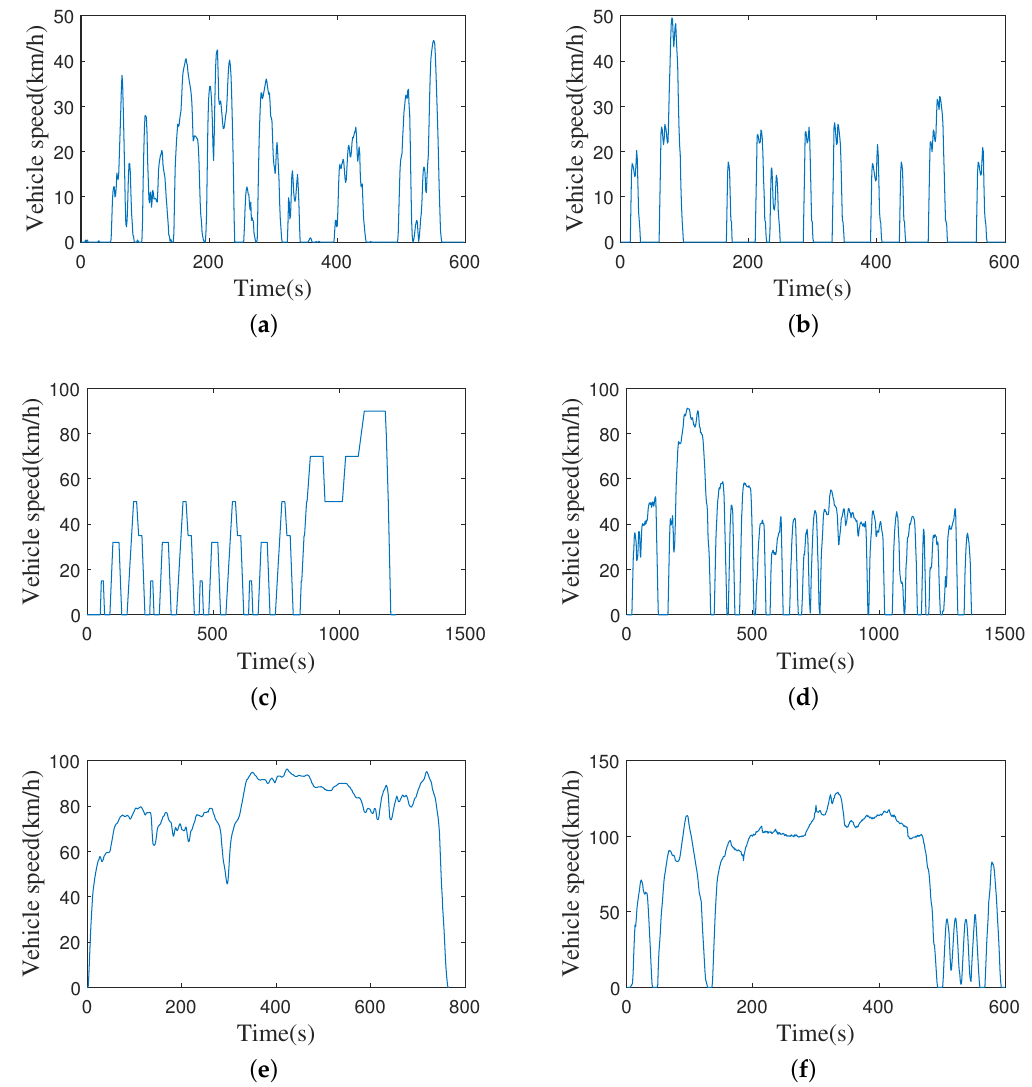
Figure 4. ( a ) NYYC. ( b ) NewYork bus. ( c ) ECE_EUDC_LOW. ( d ) UDDS. ( e ) HWFET. ( f ) US06.